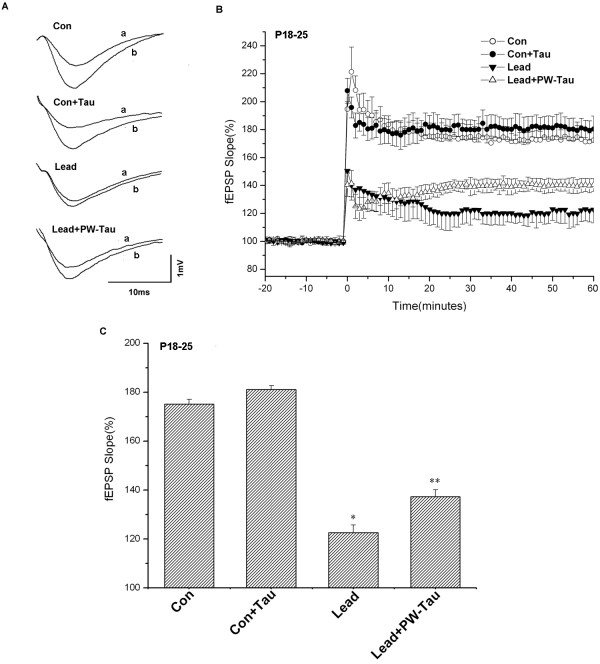
The effects of taurine on LTP induction in P18–25 groups. (A) Representative traces were recorded of field excitatory postsynaptic potentials (fEPSPs) before (a) and 60 min after (b) HFS in Con, Con+Tau, Lead and Lead+PW-Tau slices. (B) LTP was induced by stimulation at 100 Hz for 1 sec. For the sake of clarity, points are plotted every 3 min here and in subsequent LTP figures. The amplitude in the Lead group was depressed compared with that of Con group (p < 0.01). There was no significant difference in LTP amplitude between Con and Con+Tau groups (p > 0.05). The LTP amplitude in Lead+PW-Tau group was 12.0% higher than that of Lead group (p < 0.01) but still lower than that of controls (p < 0.01). (C) Histogram showing mean ± SEM percentage of fEPSP slope in 40–60 min normalized to the baseline response after HFS in Con, Con+Tau, Lead and Lead+PW-Tau subjects (Con: 175.1 ± 7.6%, n = 9; Con+Tau: 181.1 ± 8.3%, n = 8; Lead: 122.6 ± 9.6%, n = 8; Lead +PW-Tau: 137.3 ± 5.3%, n = 9). *p < 0.01, versus Con group. **p < 0.01, versus Lead group and p<0.01, versus Con group. One-way ANOVA with the Bonferroni post hoc test were used for statistical analysis.